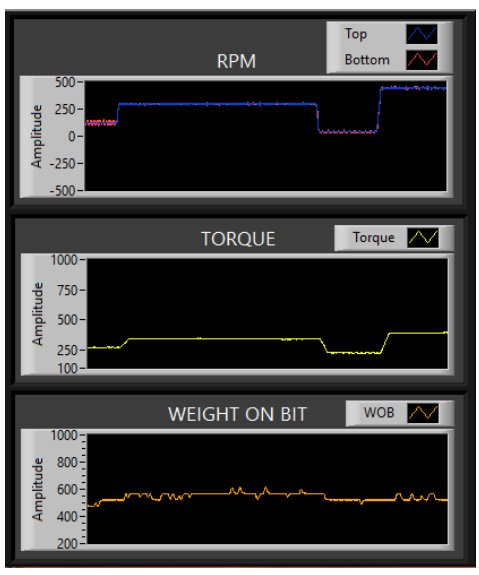
Figure 20. The plot of RPM, torque, and weight on bit (WOB) with time.